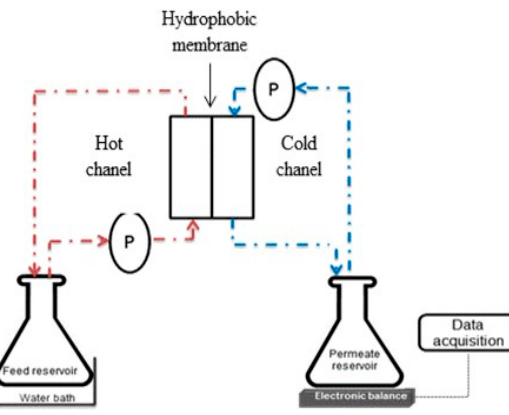
Figure 1. Experimental set ‐ up of direct ‐ contact membranedistillation(DCMD).